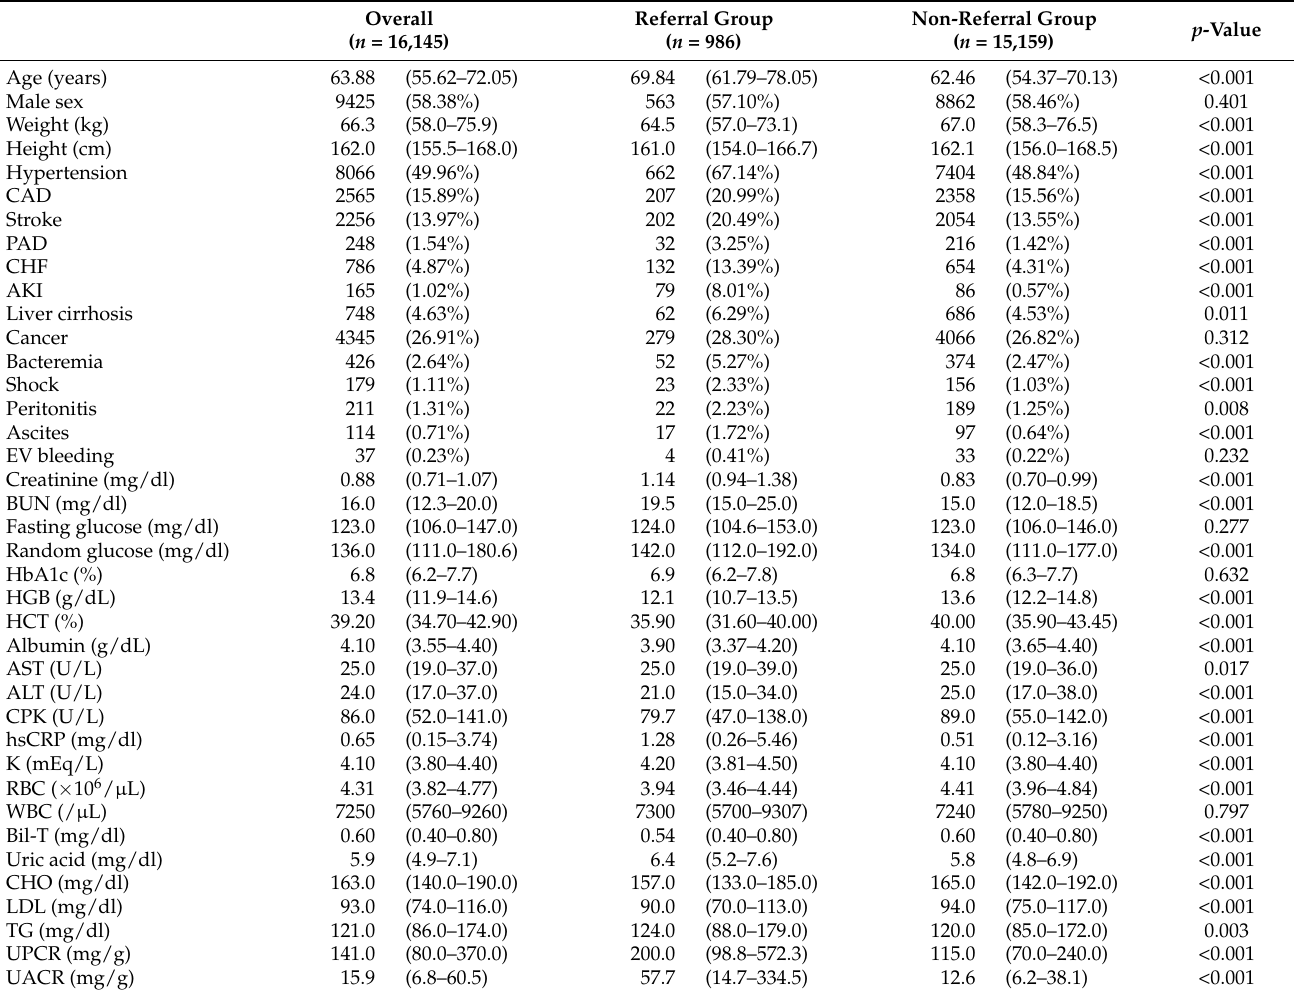
Table 3. Baseline demographic and clinical characteristics of the included patients in experiment